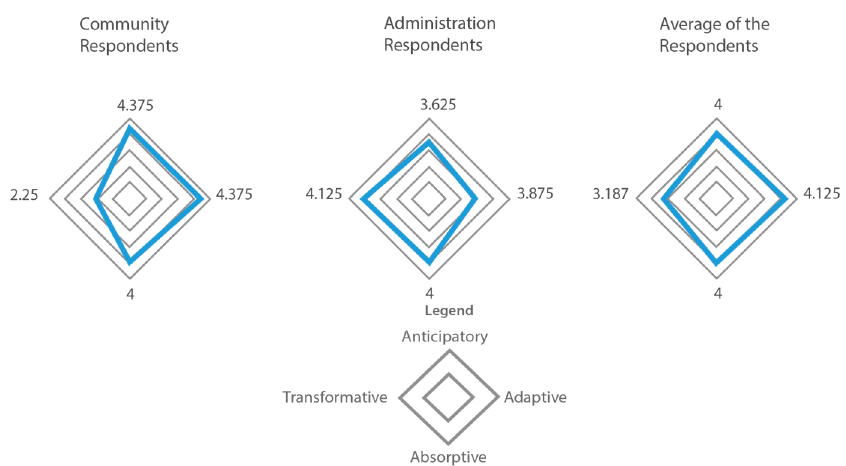
Figure 4. Average of the capacities in Chile (on a Likert scale of 1 – 5 with 5 representing the highest score).